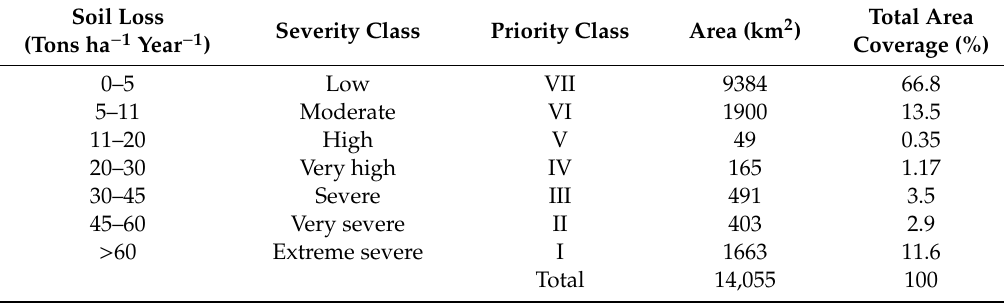
Table 5. Soil loss severity in the Welmel